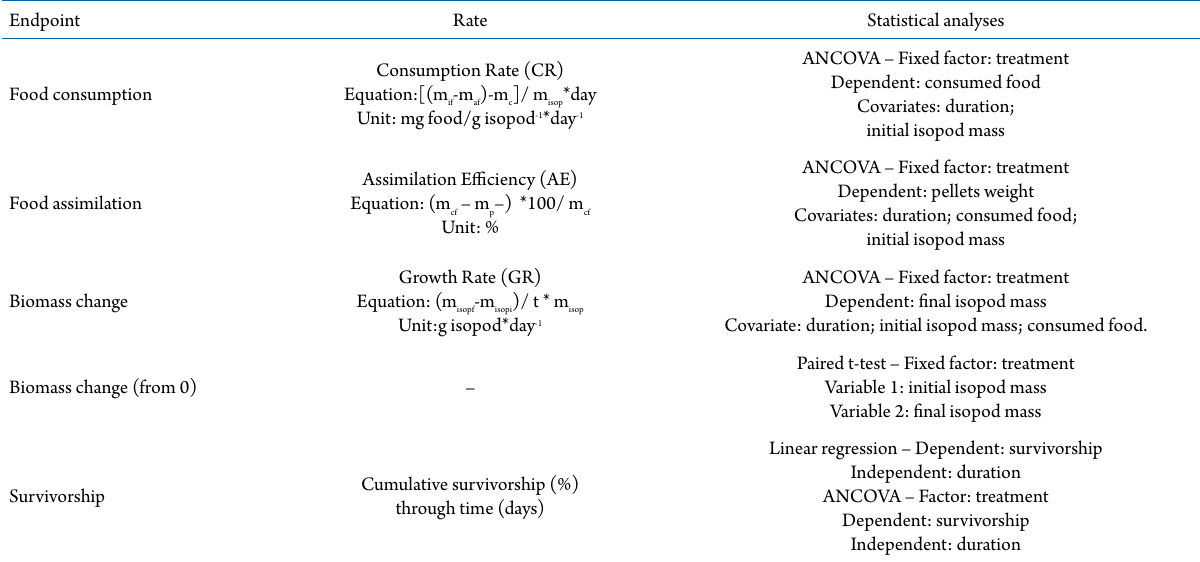
Table 1. Feeding performance endpoints with respective rate calculation (adapted from Waldbauer, 1968) and suggested statistical analyses (as proposed by Raubenheimer and Simpson, 1992) for experiments with soil invertebrates. Endpoint Rate Statistical